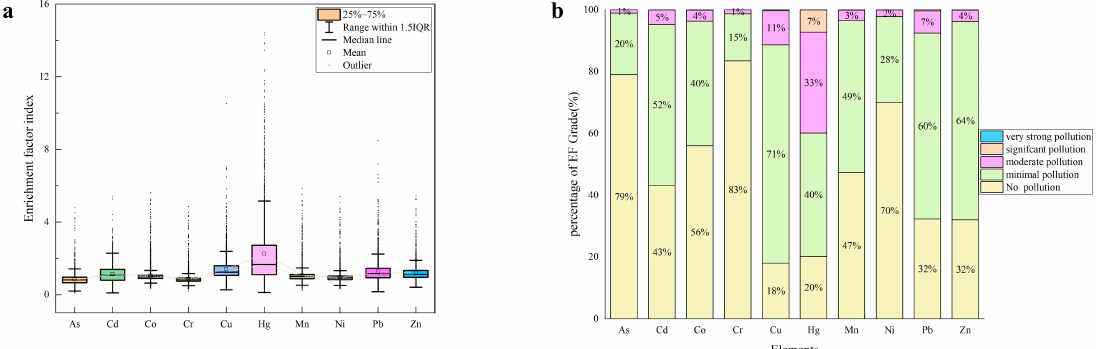
Figure 7. ( a ) geo-accumulation index (I geoi ) of HMs in Farmland soil and ( b ) the percentage of geo- accumulation index grade (%).